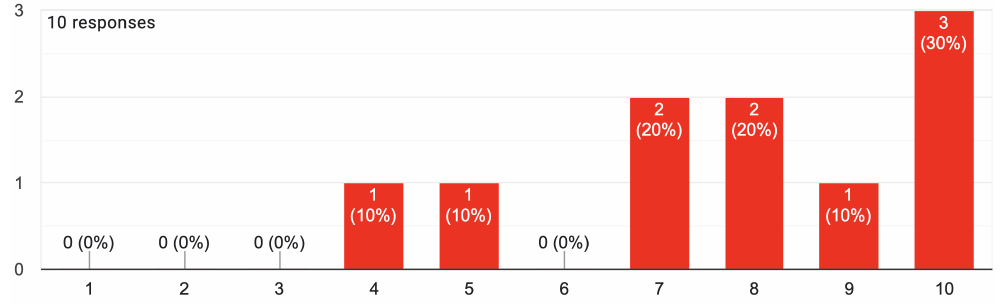
Figure 10. Feedback collected from students: on a scale of 1–10 with 1 being not engaging at all and